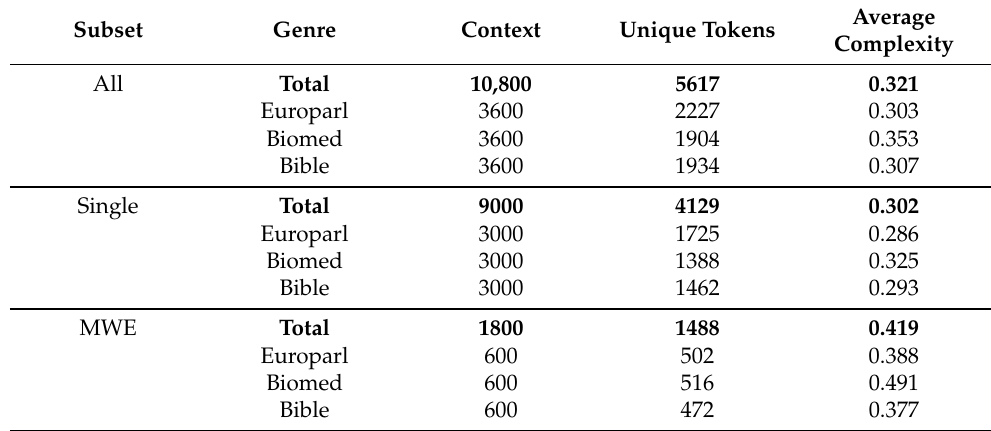
Table 2. The statistics for CompLex 2.0.